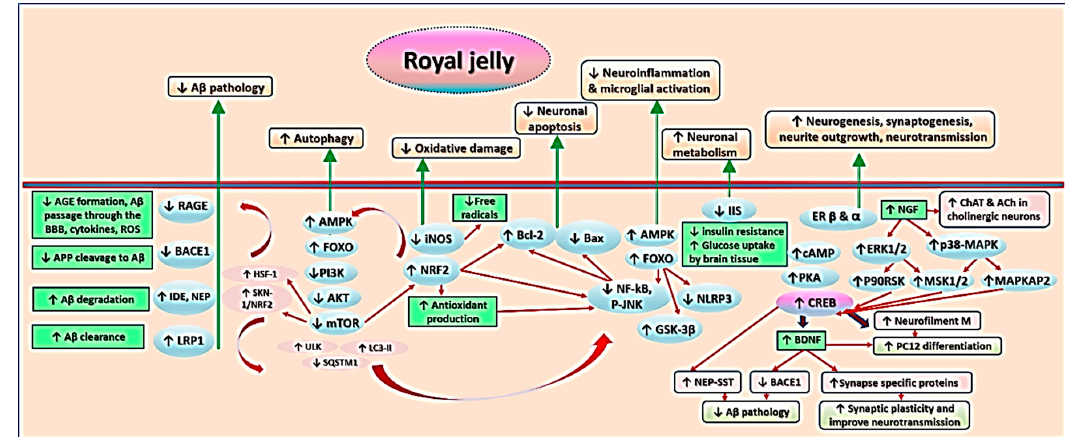
Figure 5. Possible mechanisms of action behind royal jelly-related effects in cognitive aging and Alzheimer’s disease. Abbreviations: ↑ denotes increase, ↓ denotes decrease, A β : beta-amyloid protein fragments, RAGE: receptor for advanced glycation end products, BBB: blood brain barrier, ROS: reactive oxygen species, APP: amyloid precursor protein, BACE1: beta-site APP cleaving